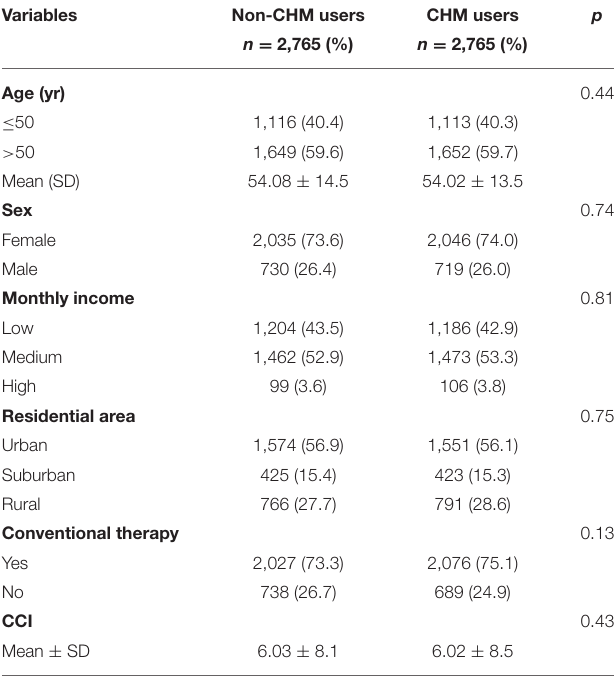
TABLE 1 | Demographic data and selected comorbidities of study